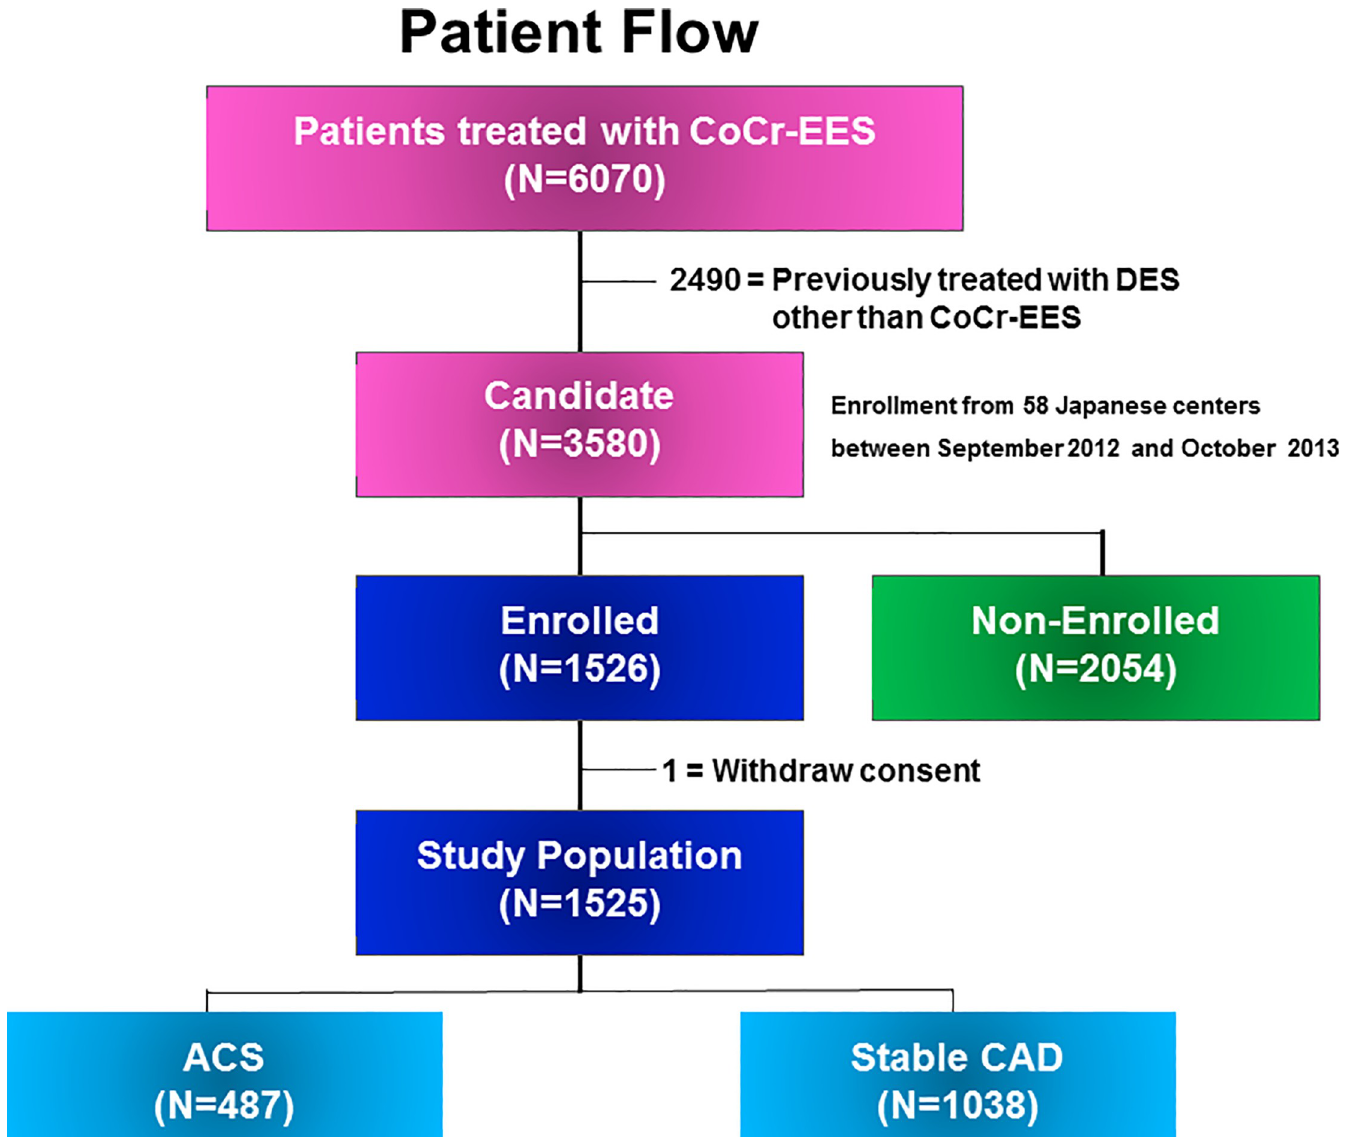
Fig 1. Study flow chart. CoCr-EES, Cobalt-chromium everolimus-eluting stent; DES, drug-eluting stent; ACS, acute coronary syndrome; CAD, coronary artery disease.